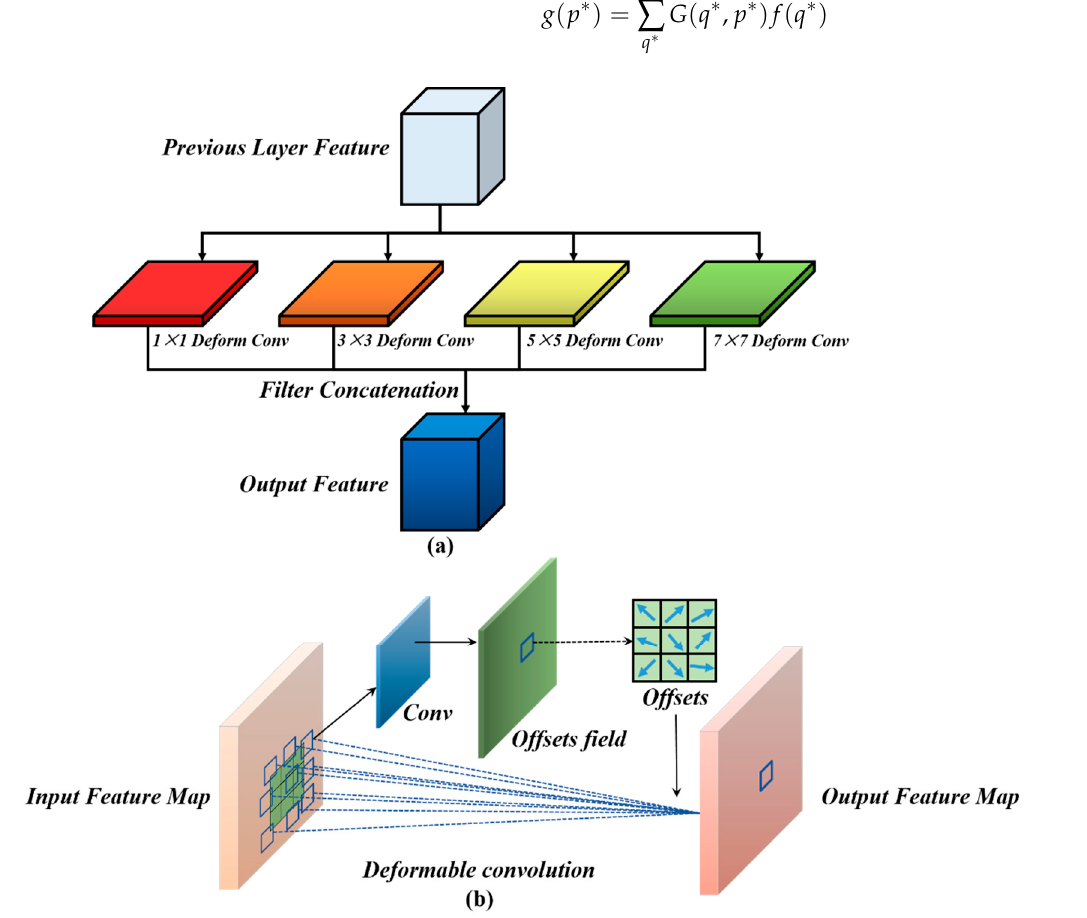
Figure 5. ( a ) The details of the MFF module. ( b ) The implementation of deformable